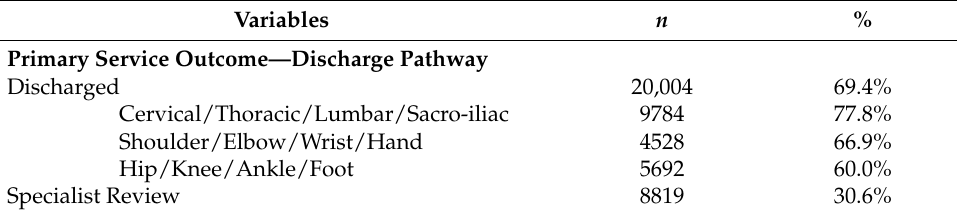
Table 2. Service outcomes and explanatory variables presented as the number ( n ) and propor- tion (%) of patients within each category. The primary service outcome was a discharge pathway, dichotomised as either discharged from the service with no specialist medical review required (Discharged) or reinstated for specialist medical review (Specialist